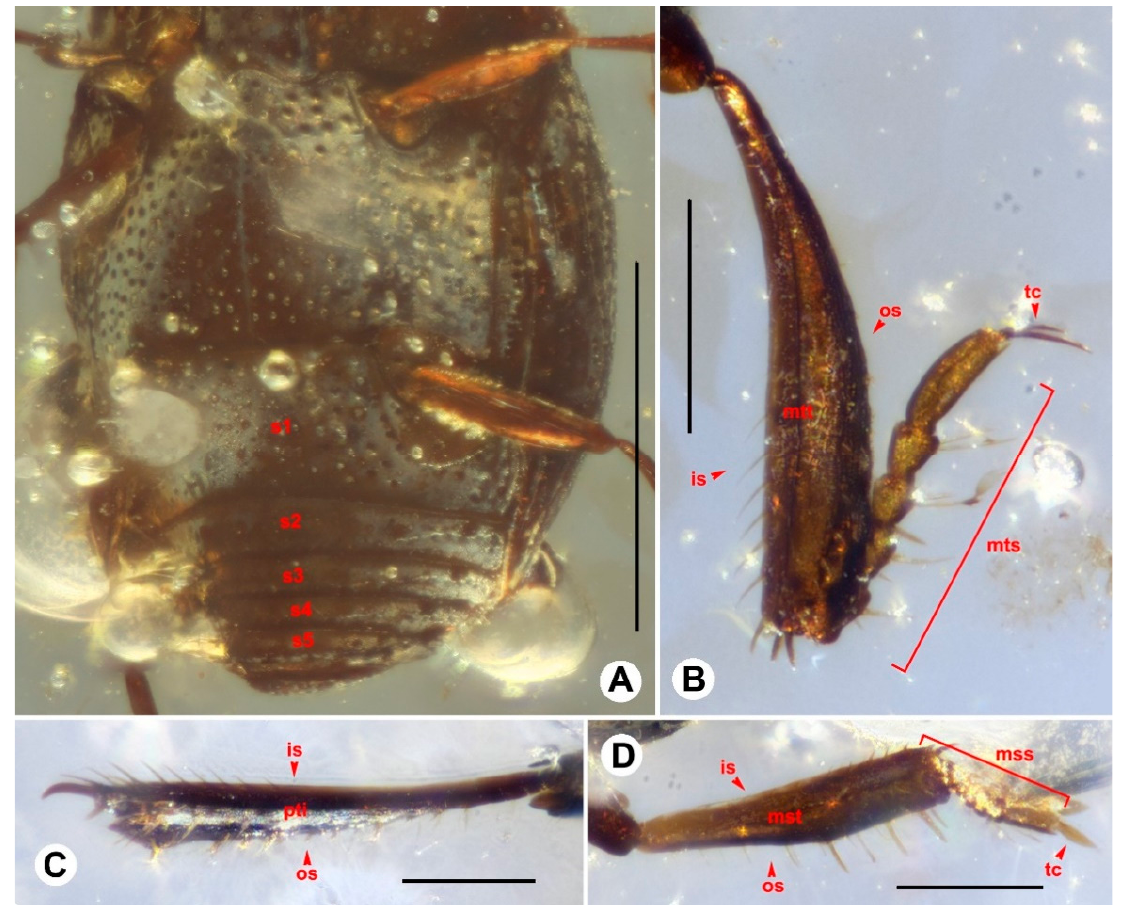
Figure 3. Diagnostic features of Anapleus kachinensis sp. nov., holotype, GUGC-FOSSIL-0002. ( A ) Abdomen. ( B ) Metatibia. ( C ) Protibia. ( D ) Mesotibia. Scale bars: 0.5 mm in ( A ), 0.1 mm in ( B – D ). Abbreviations: s1–5, sterna III–VII; is, inner side; os, outer side; pti, protibia; mst, mesotibia; mss, mesotarsus; mtt, metatibia; mts, metatarsus; tc, tarsal